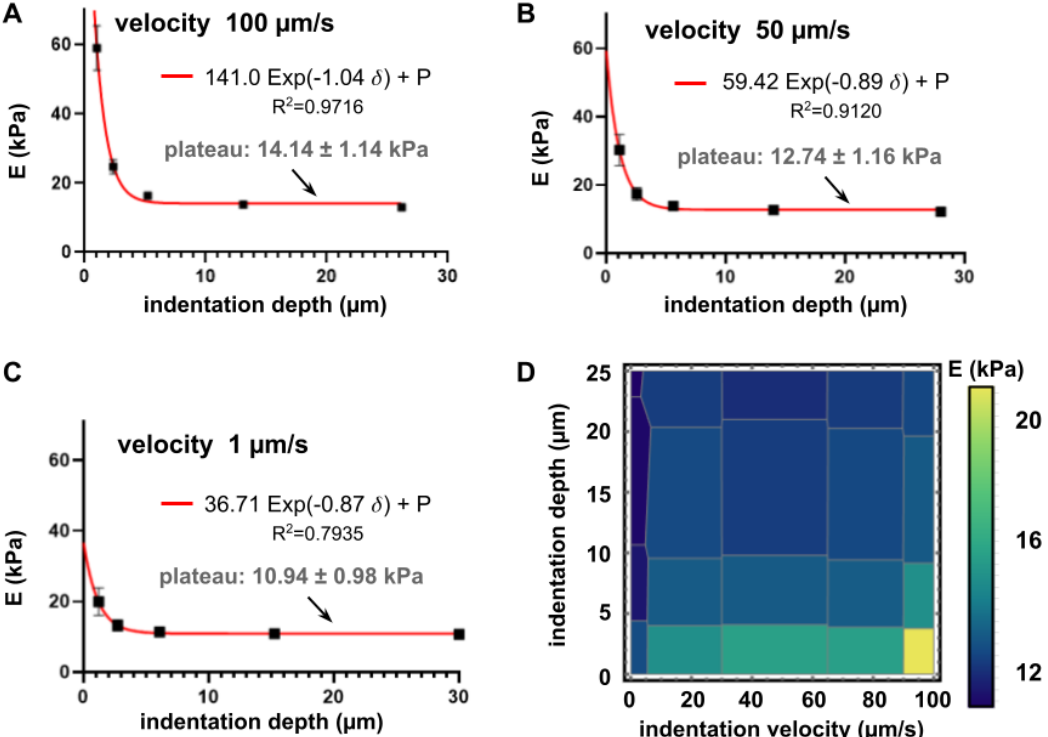
Figure 3. Influence of velocity and depth of indentation on the computed Young’s modulus of a 4 kPa PAM hydrogel, measured in a detergent solution of ddH 2 O + 0.1% extran. Panels A – C present the results for velocities of 1, 50 and 100 µm/s respectively. The values presented correspond to calculations using a Hertz model fitting. By increasing the indentation depth, the fitted modulus decreases down to a plateau level of 14.14 ± 1.14 kPa, 12.74 ± 1.74 kPa and 10.94 ± 0.98 kPa, respectively. It was possible to fit those values to exponential decays as a function of the indentation depth, shown in the legend of each graph. In addition to the velocities shown in panels A – C, velocities of 80 and 10 µm/s were tested and shown in the density diagram of panel D . This graph is divided into different Voronoi regions (grey mesh) to visually present the influence of velocity and indentation depth. In panels A – C, error bars represent the mean standard deviation and when not visible, they are smaller than the data point visible dimension.